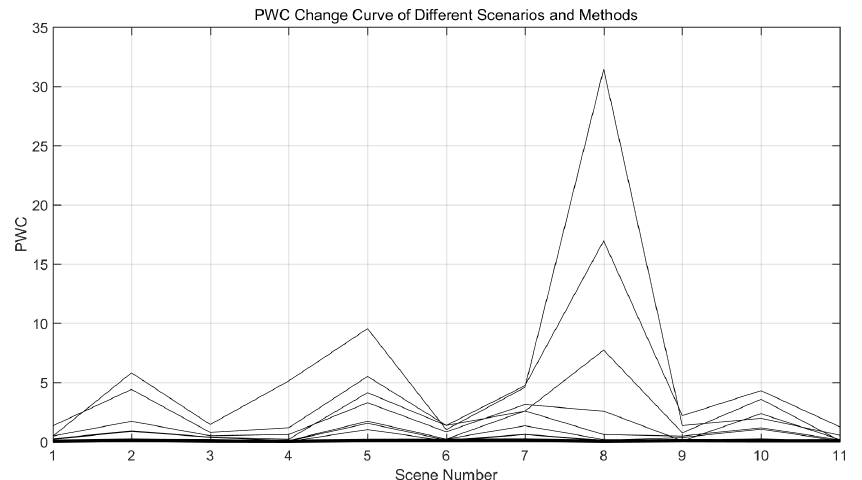
Figure 7. Change curve of PWC relative to each category of the dataset: the bold curve represents the change curve of PWC value of each category corresponding to the method in this paper, which is one of the several broken lines closest to the straight line 0, indicating that our method has a low segmentation error rate in each